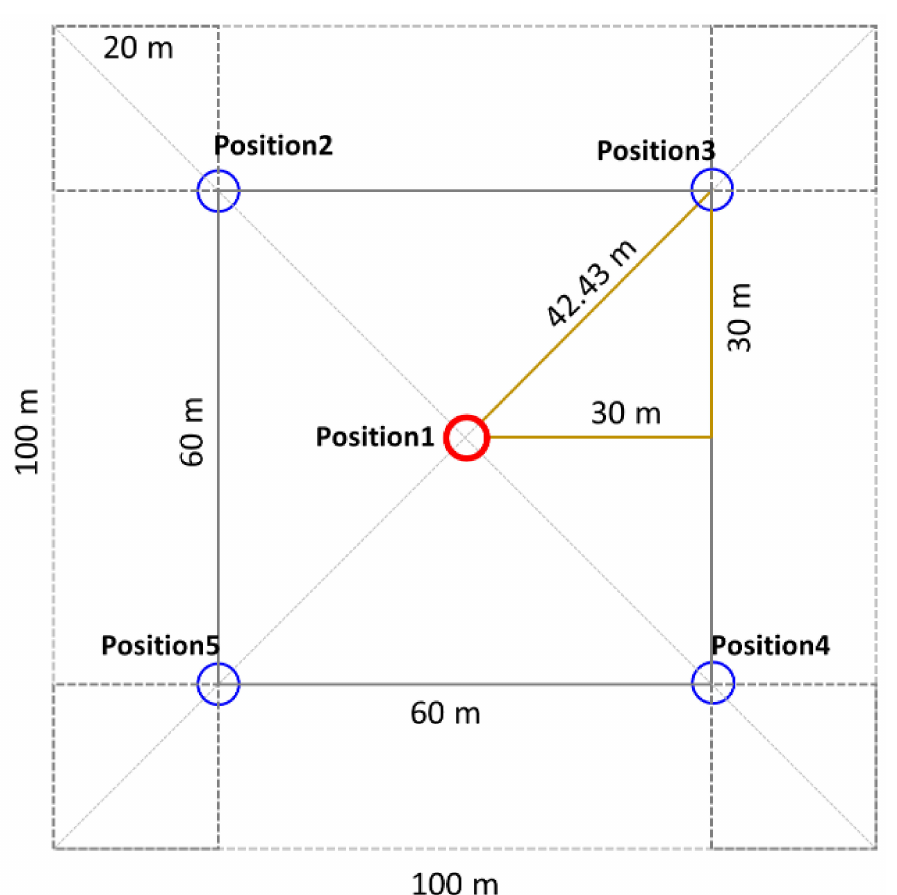
Figure 2. Sampling scheme at each plot with five scans per plot and a five-on-a-dice-like setup. The number of plots varied across sites, as depicted in Table 1, due to varying sizes of the investigated forest patches and